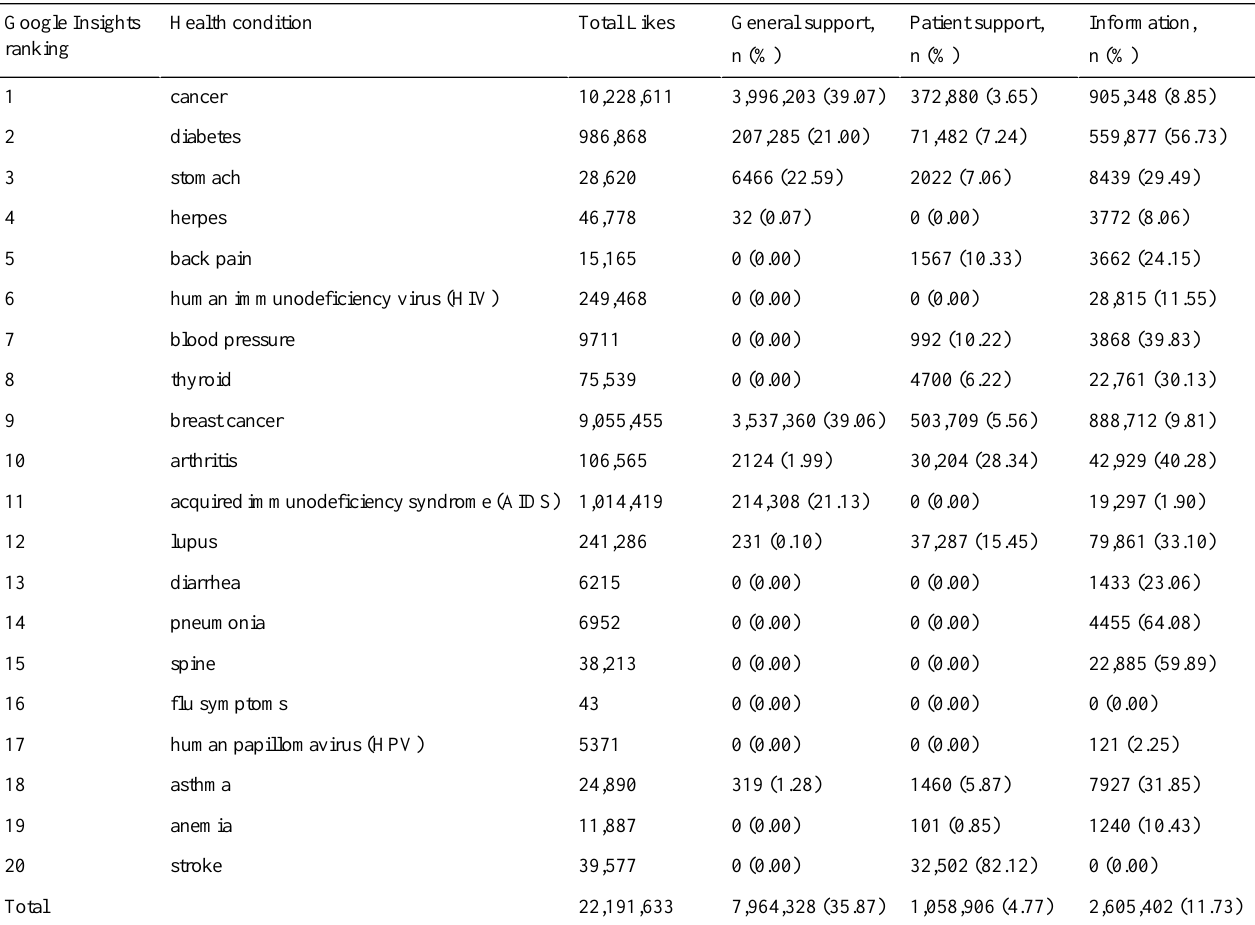
Table 7. Facebook “Likes” by health condition and content—General Support, Patient Support, and Information/Awareness.